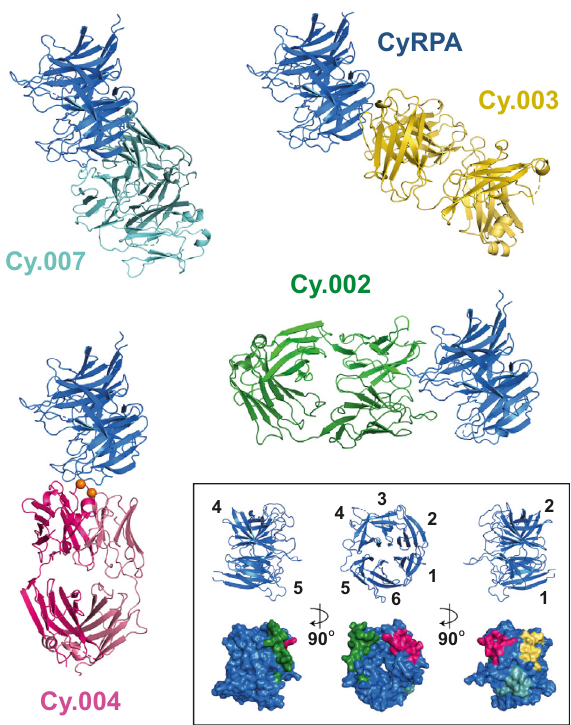
Fig. 2 Determining the epitopes for inhibitory and non-inhibitory antibodies targeting CyRPA. Crystal structures of Fab fragments of Cy.002 (green), Cy.003 (yellow), Cy.004 (dark pink), and Cy.007 (light blue), each bound to CyRPA (blue). Within the inset box (bottom right) we show three different views of CyRPA, each rotated by 90°. The upper row “ cartoon ” images show the six blades of the CyRPA β -propeller. The lower row shows the CyRPA surface (blue) with binding epitopes indicated using the same colours as the antibody